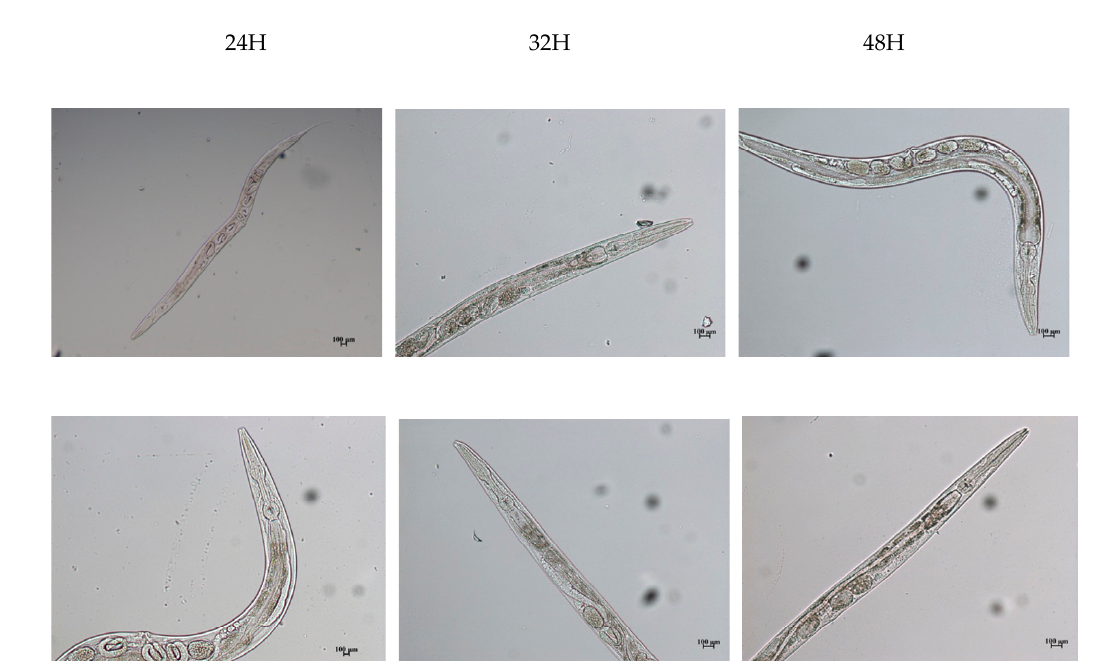
Figure 3. Status of model animal, C. elegans , during exposure studies. Young adult C. elegans were exposed to PEs and the impact on reproduction/development was compared with the controls. Representative images showing the spatiotemporal (20 × ) effect of biochanin A ( bottom panel ) on the model animal, C. elegans , when compared to the control ( top panel ) OP50 (food source).